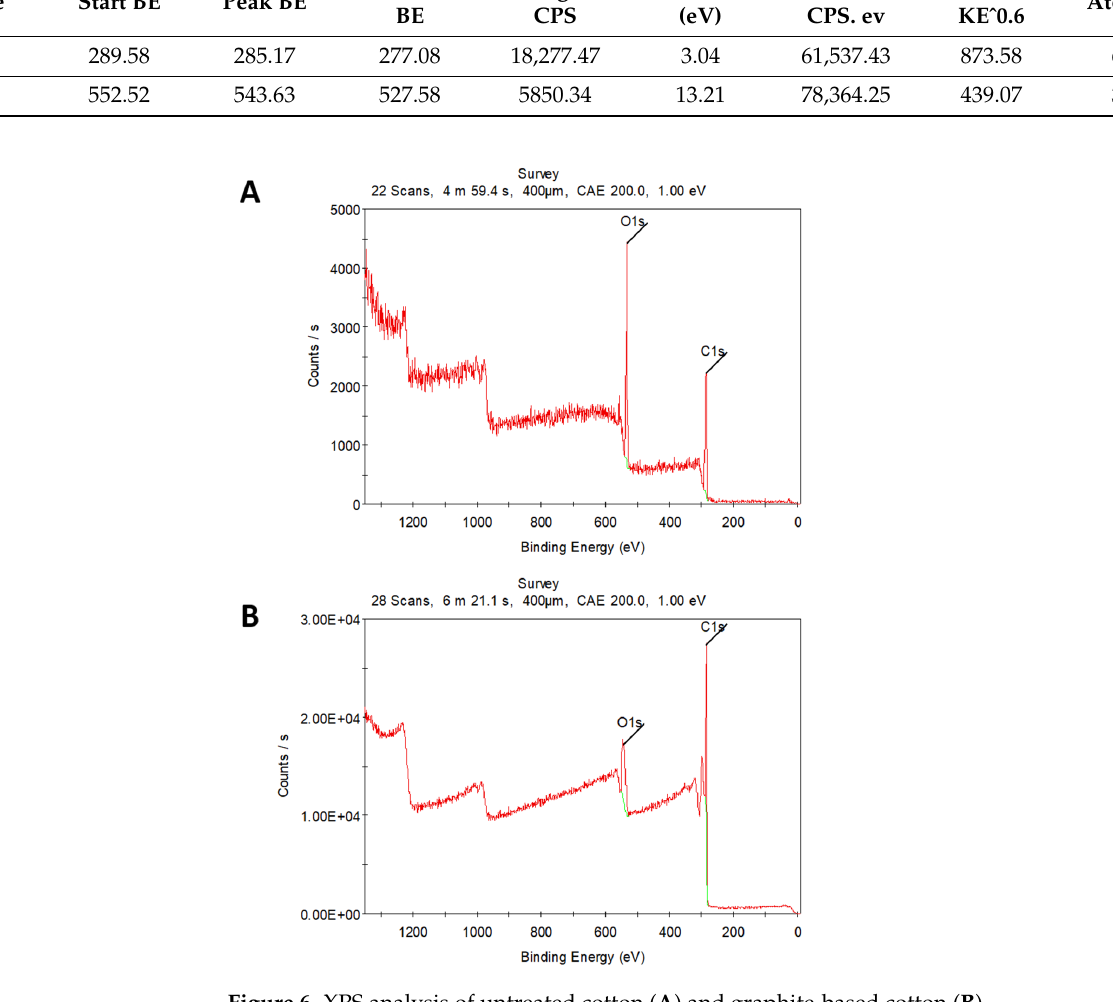
Figure 6. XPS analysis of untreated cotton ( A ) and graphite-based cotton ( B ).